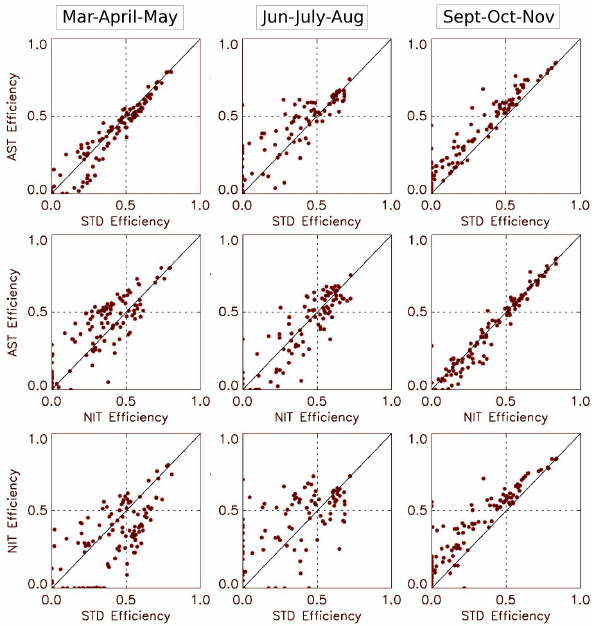
Fig. 10. Seasonal intercomparison of the various LSM-TRIP sim- ulations over the CNF area through scatter-plots of river flow Eff values over the 1991–2008 period: (top panel) AST vs. STD, (mid- dle panel) AST vs. NIT, and (bottom panel) NIT vs. STD. From left to right: spring, summer and autumn. Negative Eff values are represented by 0.